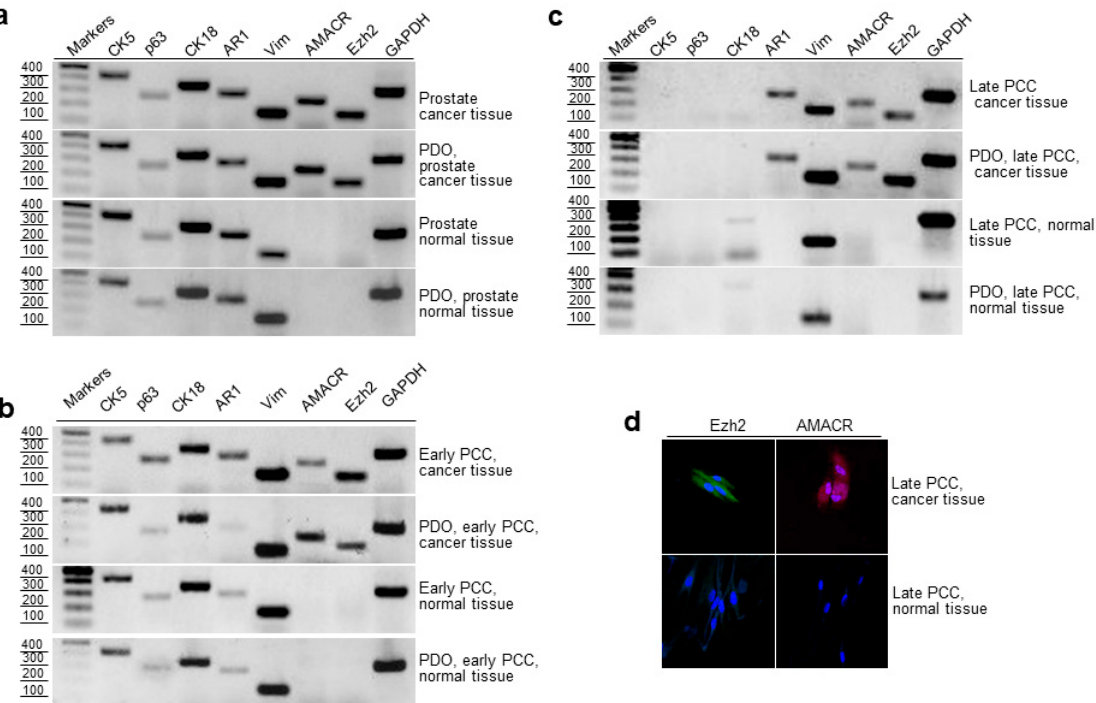
Figure 4. RT-PCR evaluation of epithelial, mesenchymal, and cancer markers in the cancerous and normal prostate tissue, PCCs, and PDOs. ( a ) Expression of epithelial (CK5, CK18, p63, AR1), mesenchymal (vimentin), and cancer (AMACR and EZH2) markers in ( a ) PCaT and surrounding normal tissue and derived PDOs; ( b ) early PCCs and derived PDOs; ( c ) late PCCs and derived PDOs; ( d ) Immunofluorescence staining of EZH2 and AMACR in late PCCs derived from the cancerous and normal prostate tissues (nuclei were stained with DAPI). The images were captured with a scanning confocal microscope (Leica Microsystems, Wetzlar, Germany) using 405, 488, and 633-nm lasers, objective, ×40.